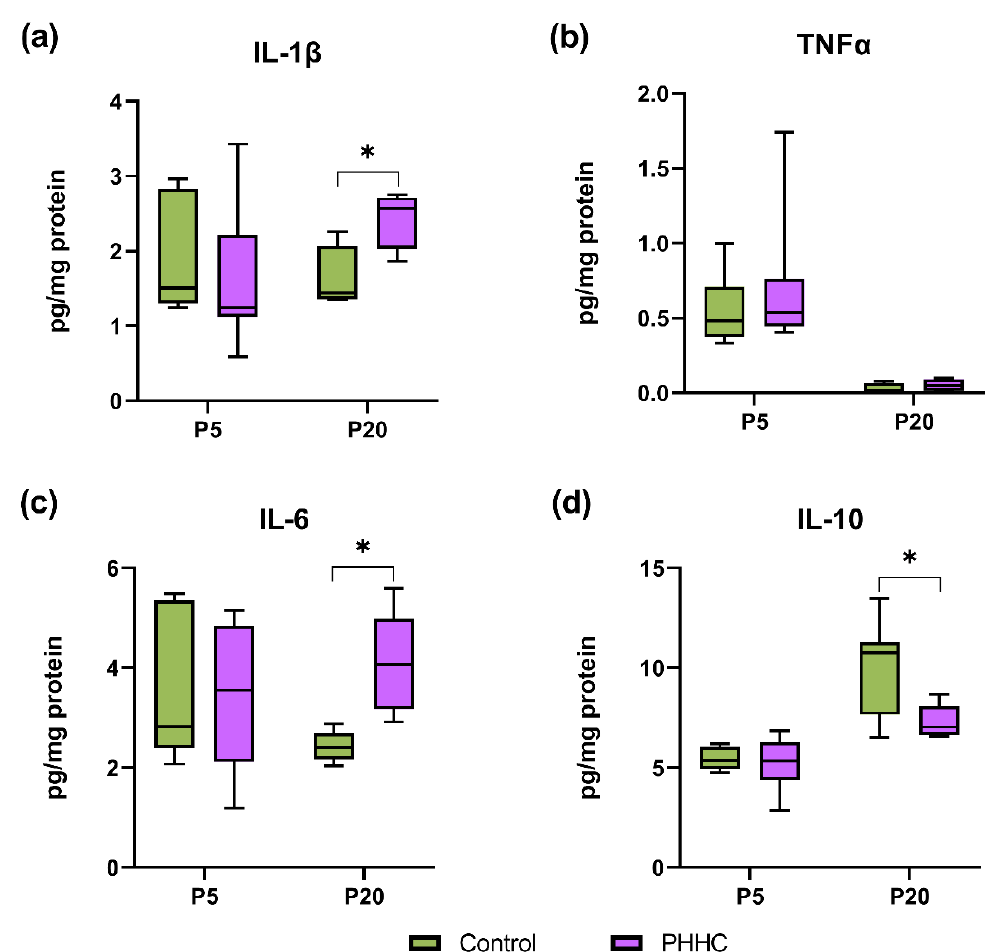
Figure 4. Effect of maternal hyperhomocysteinemia on the content of cytokines in the rat pup hippocampus. PHHC, prenatal hyperhomocysteinemia. ( a ) IL-1 β content in the hippocampus of rats on P5 and P20 in the control ( n = 7) and PHHC ( n = 9) groups. ( b ) TNF α level in the hippocampus of rats on P5 and P20 in the control ( n = 7) and PHHC ( n = 9) groups. ( c ) IL-6 content in the hippocampus of rats on P5 and P20 in the control ( n = 7) and PHHC ( n = 9) groups. ( d ) IL-10 level in the hippocampus of rats on P5 and P20 in the control ( n = 7) and PHHC ( n = 9) groups. Data represent Me (25th, 75th percentile), whiskers—min-max. All samples were run in triplicate. Significance of difference between the PHHC and control groups were determined by the Student’s t -test (* p ≤